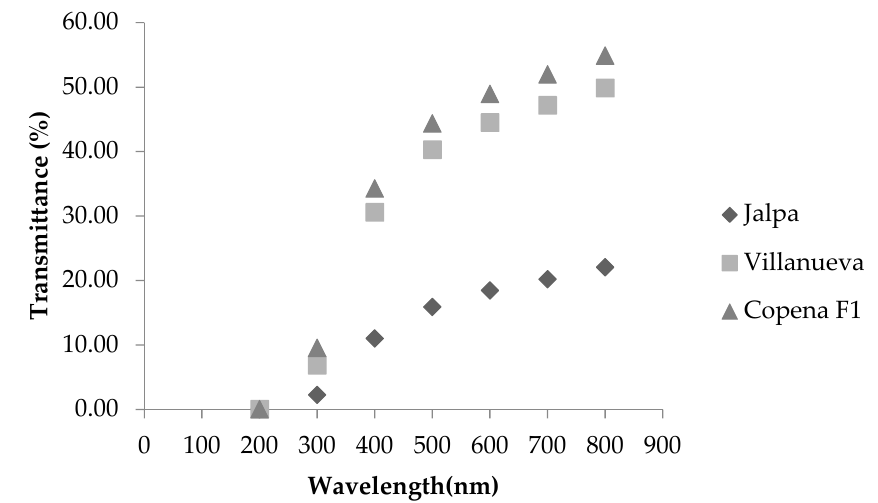
Figure 3. Light transmission rate (%) of edible films based on the mucilage of three cultivars of Opuntia ficus-indica at wavelengths from 200 to 800 nm. Table 2. Viscosity (mPa × s) of formulations based on the mucilage of three cultivars of Opuntia ficus-indica ; revolutions per minute (RPM) from 20 to